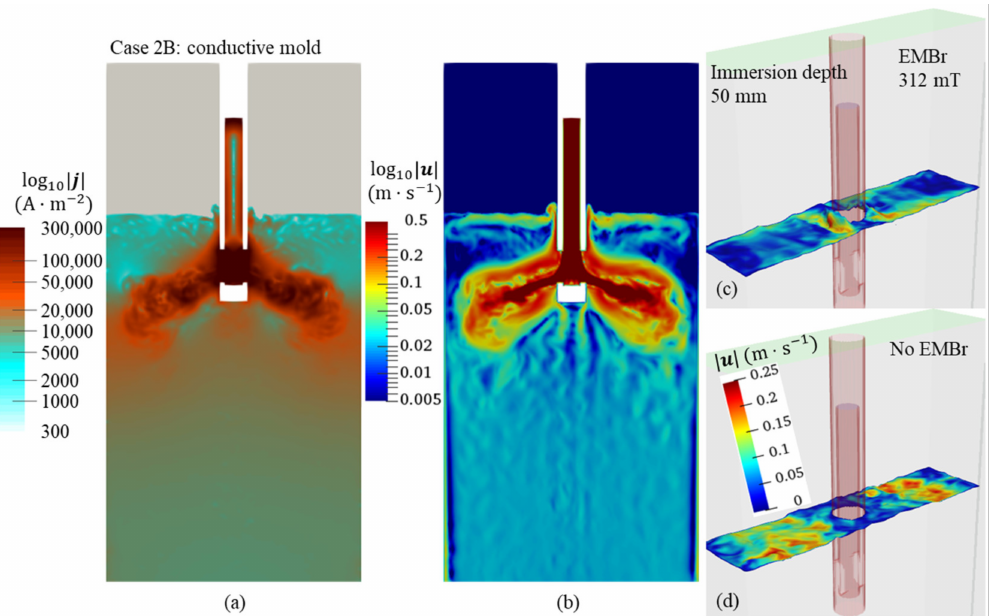
Figure 11. Meniscus flow for Case 2B: ( a ) induced e-current density and ( b ) melt velocity (midplane); ( c ) interface velocity with EMBr compared with ( d ) Case 0B without EMBr.